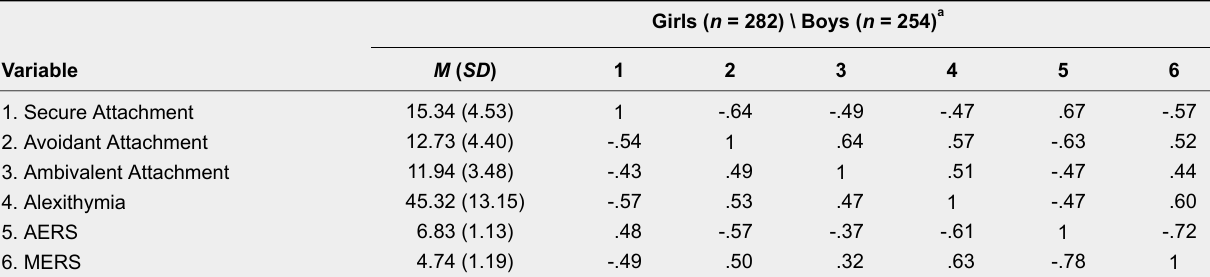
a Top right of table represents correlations for boys and the bottom left of the table represents the correlations for girls. All p values <